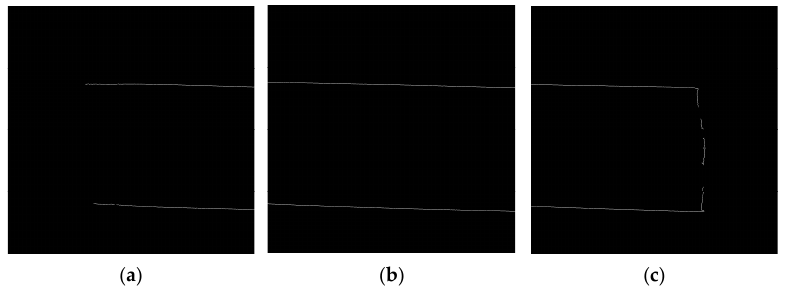
Figure 6. The ground truth images of plate nuclear fuel elements obtained by Canny for FOM evaluation: ( a ) left; ( b ) middle; ( c ) right. Table 3. Result of the edge evaluation method based on FOMs.